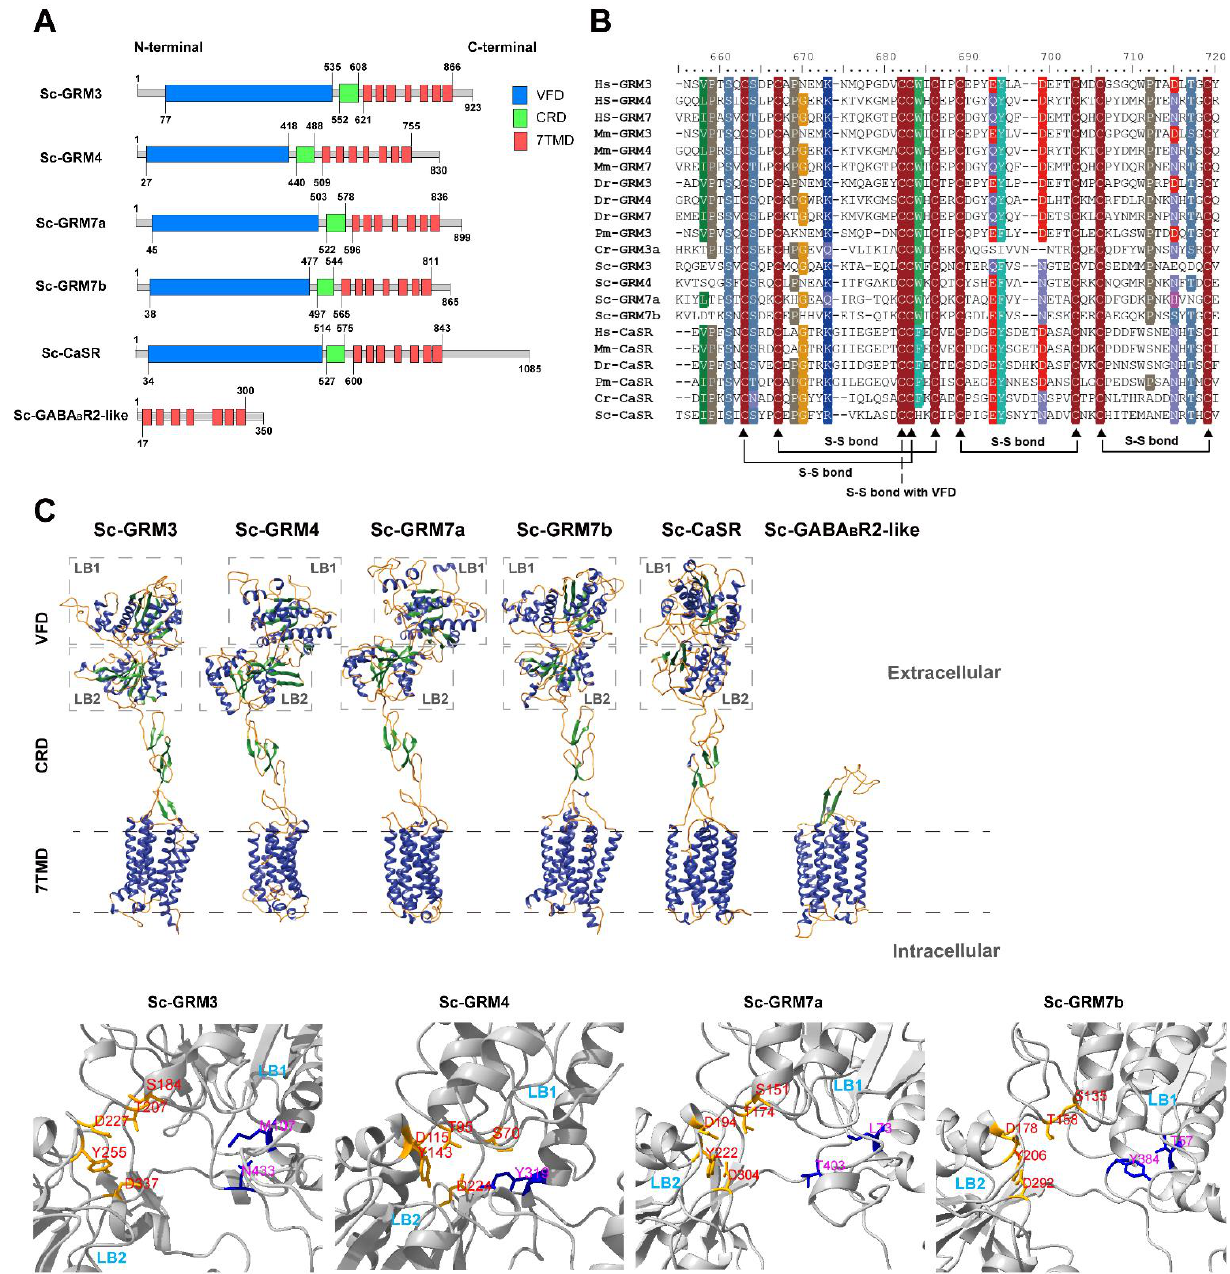
Figure 3. Functional domain and tertiary structure prediction of S. clava Class C GPCRs. ( A ) The functional domains are indicated by blue (VFD), green (CRD), and red (7TMD) boxes. ( B ) Sequence alignment of CRDs for representative GRMs and CaSRs in different species. The conserved residues are shaded. The highly conserved cysteines are indicated by black triangles. The putative disulfide bridges formed within CRD and with VFD [39] are marked out below the alignment using solid and dashed lines, respectively. ( C ) The tertiary structures were predicted based on homology modeling in the Swiss Model and visualized in the Ribbon diagram, in which the α - helices, β -sheets, and random coils are shown in blue, green, and orange, respectively. The VFD of each receptor contains lobe 1 (LB1) and lobe 2 (LB2). In the VFD of each Sc-GRM, the putative ligand-binding pocket is shown in detail. Five of seven residues important for L-glutamate binding are conserved in Sc-GRMs: conserved residues in orange and non-conserved resides in blue.